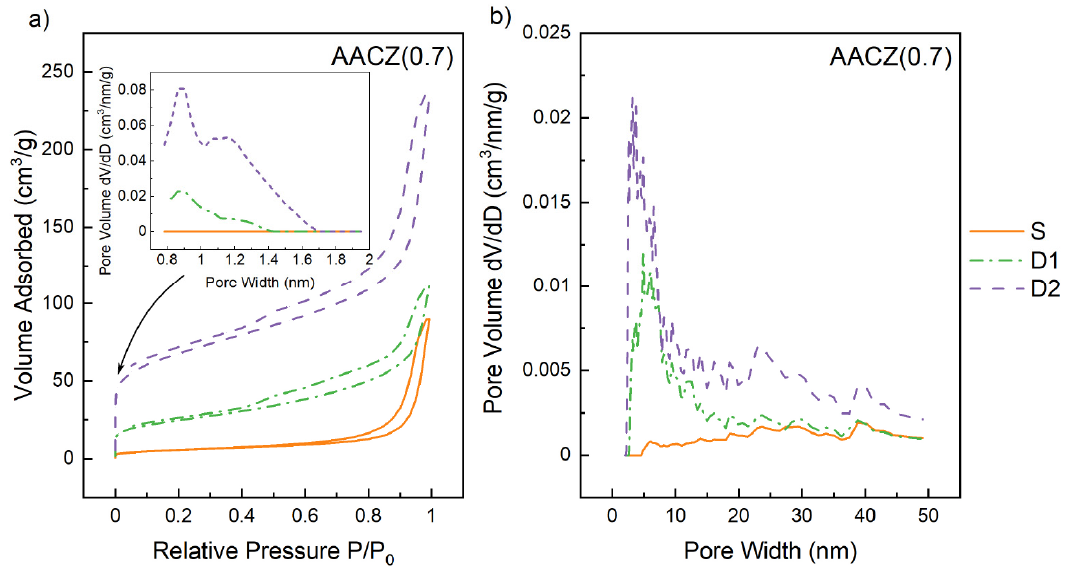
Figure 7. Adsorption/desorption isotherms and micropore size distributions (0.7–2 nm) ( a ) and mesopore size distributions (2–50 nm) ( b ) of AACZ (0.7) samples determined by N ₂ physisorption.